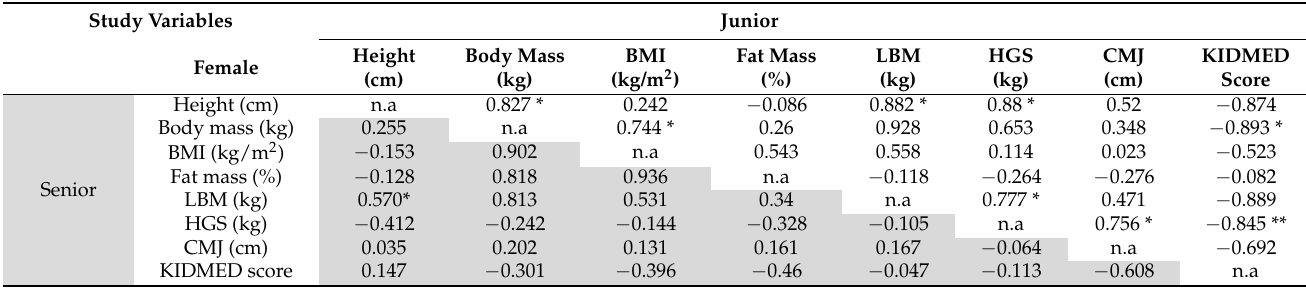
Table 5. Female beach handball players’ correlation between body composition, performance and MD adherence variables. Study Variables